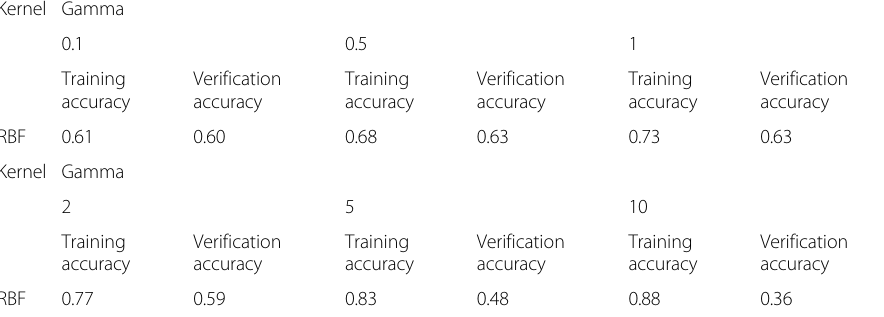
Table 7 Results using the third dataset Kernel